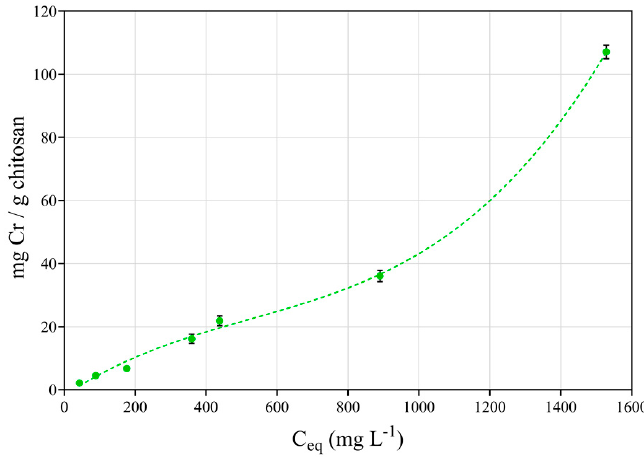
Figure 4. Adsorption isotherm at 20 ◦ C, C 0 = 50–2000 mg L − 1 , and pH =